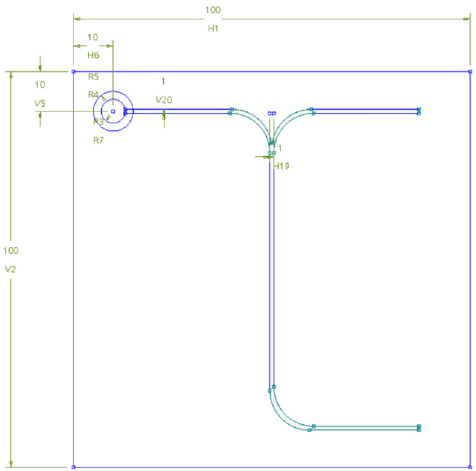
Figure 1. Model structure of microfluidic chip with microchannel. Computational fluid dynamics [18] are used to simulate and observe the mixing of blood and reagents in the mixed-flow field in a microchannel. The convection